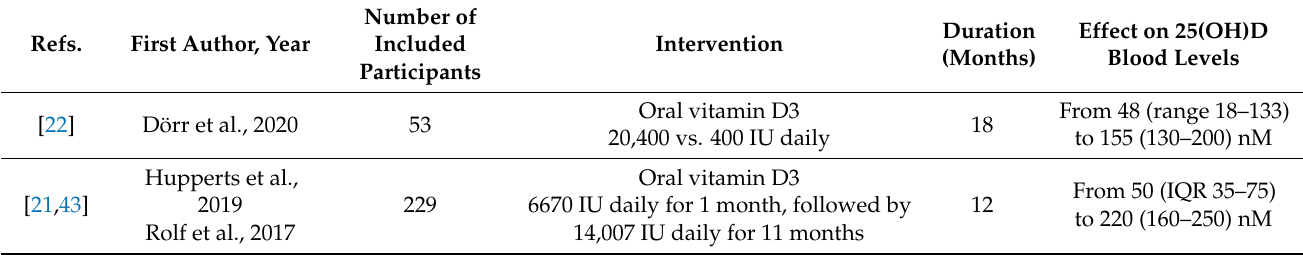
Table 4. Intervention protocols and effects of the vitamin D supplementation on 25(OH)D blood levels.